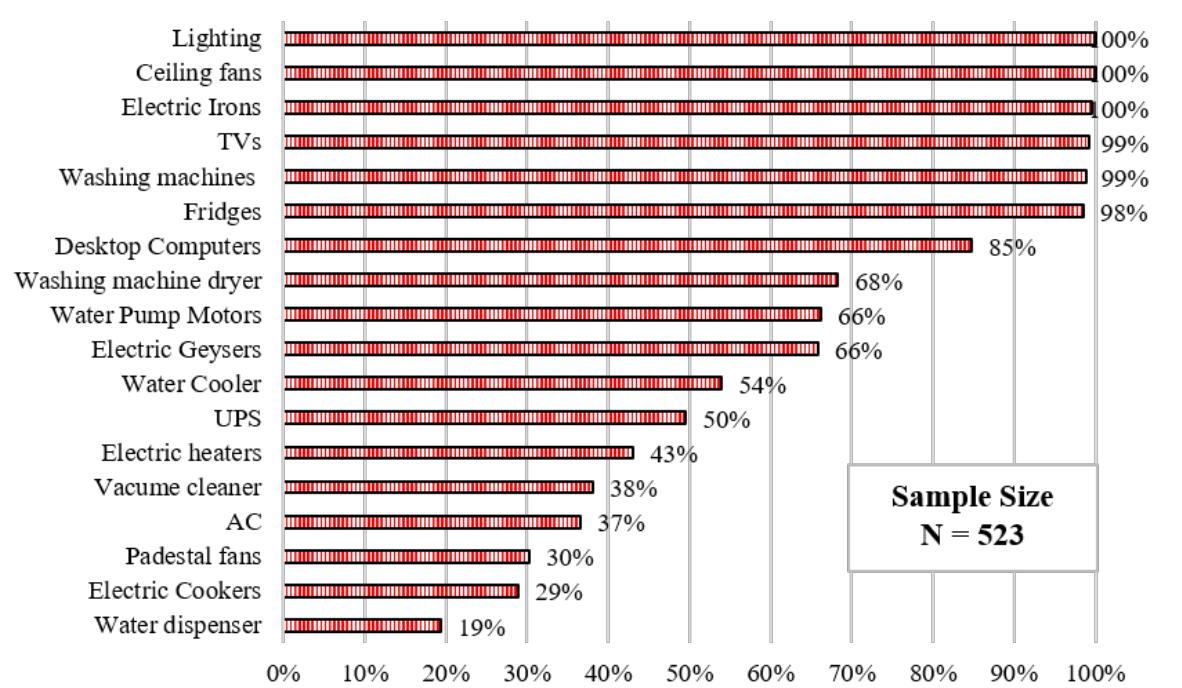
Figure 7. Percentage of appliance ownership in a typical household.